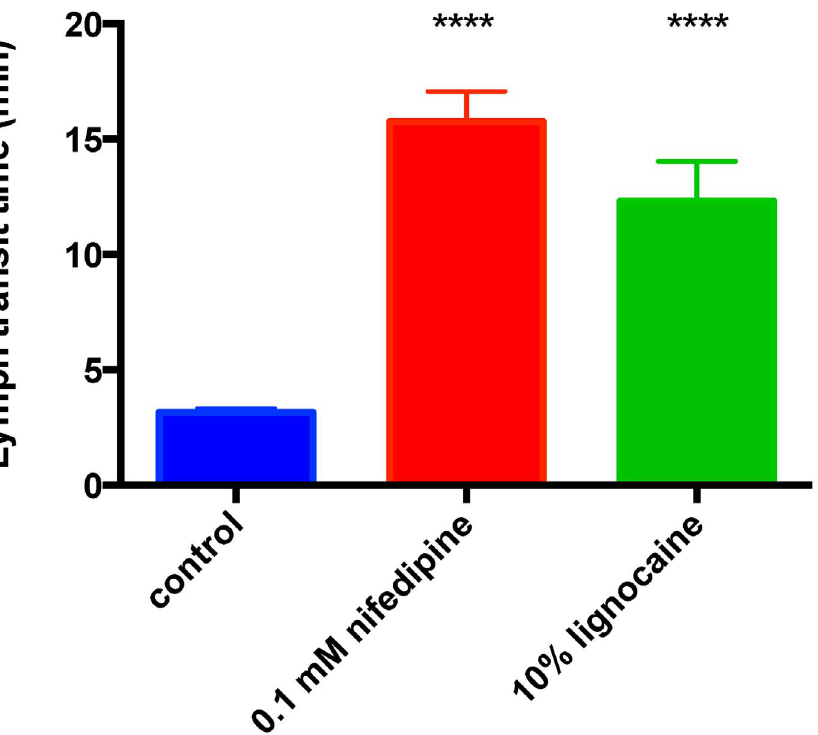
Figure 1. Effectiveness of the L-Ca channel blocker nifedipine and the local anesthetic lignocaine in inhibiting lymph flow in the rat hind limb. Foot to groin lymph transit times were measured using the marker dye India ink injected into a hind foot of each anaesthetized rat under control conditions or when the corresponding hind limb was covered with the topical pharmacological agent. The pharmacological agents all significantly increased transit times compared to control. Asterisks indicate significant differences with respect to control obtained by one-way